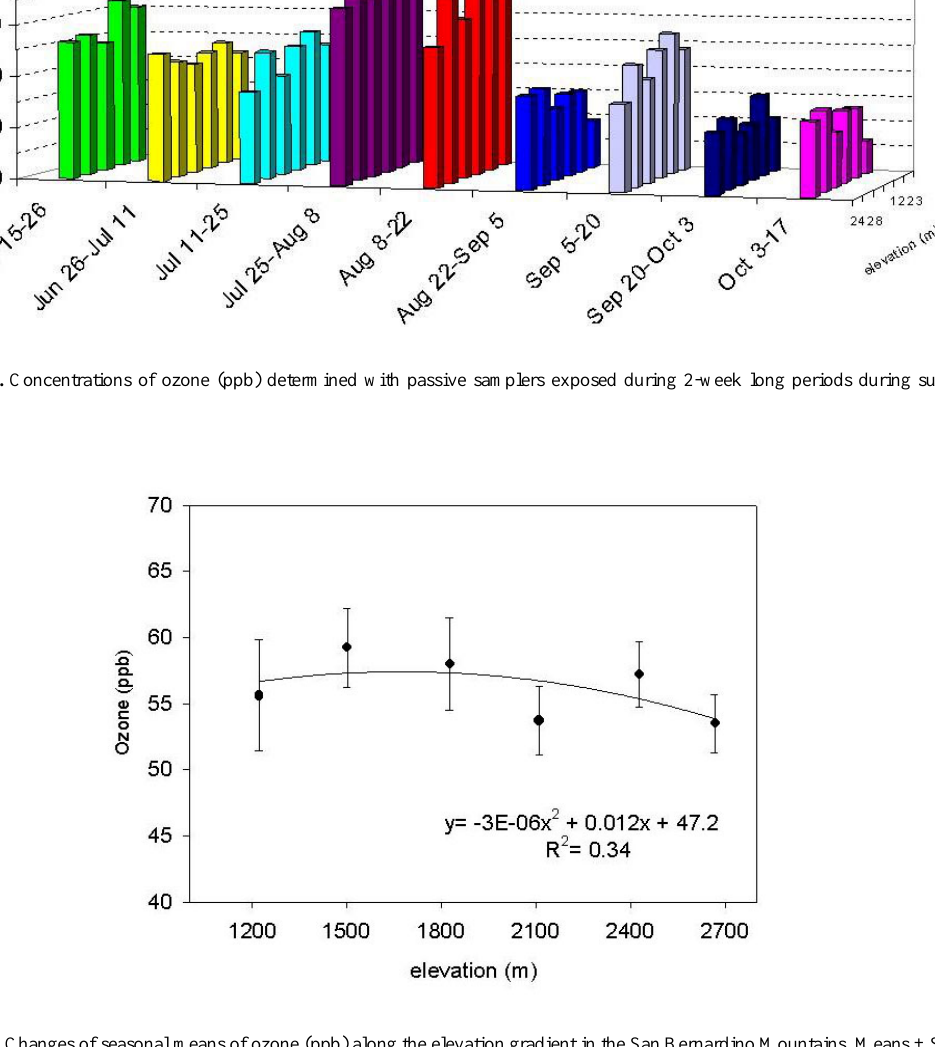
FIGURE 5. Changes of seasonal means of ozone (ppb) along the elevation gradient in the San Bernardino Mountains. Means ±